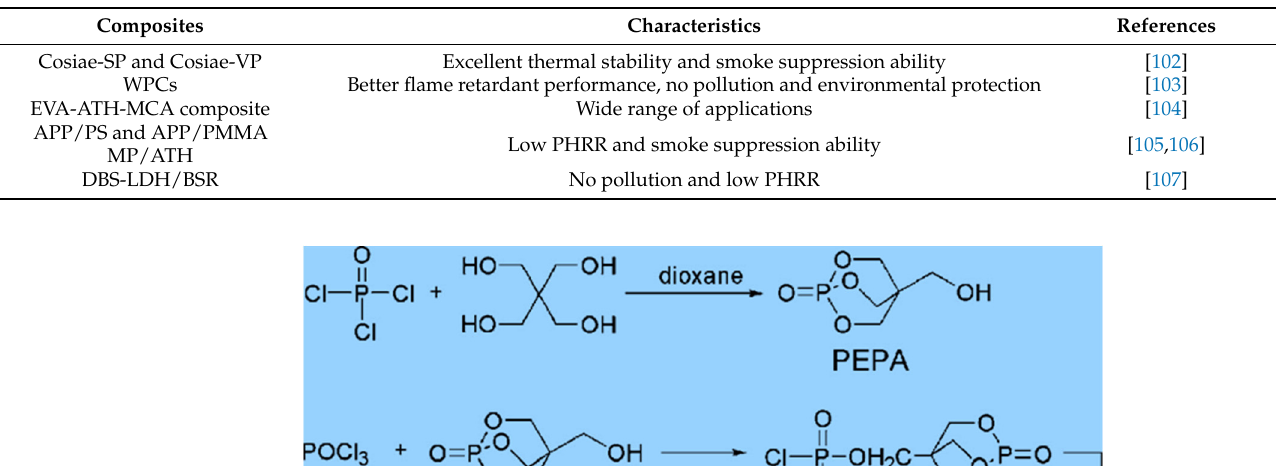
Table 2. Inorganic flame retardants and their characteristics.